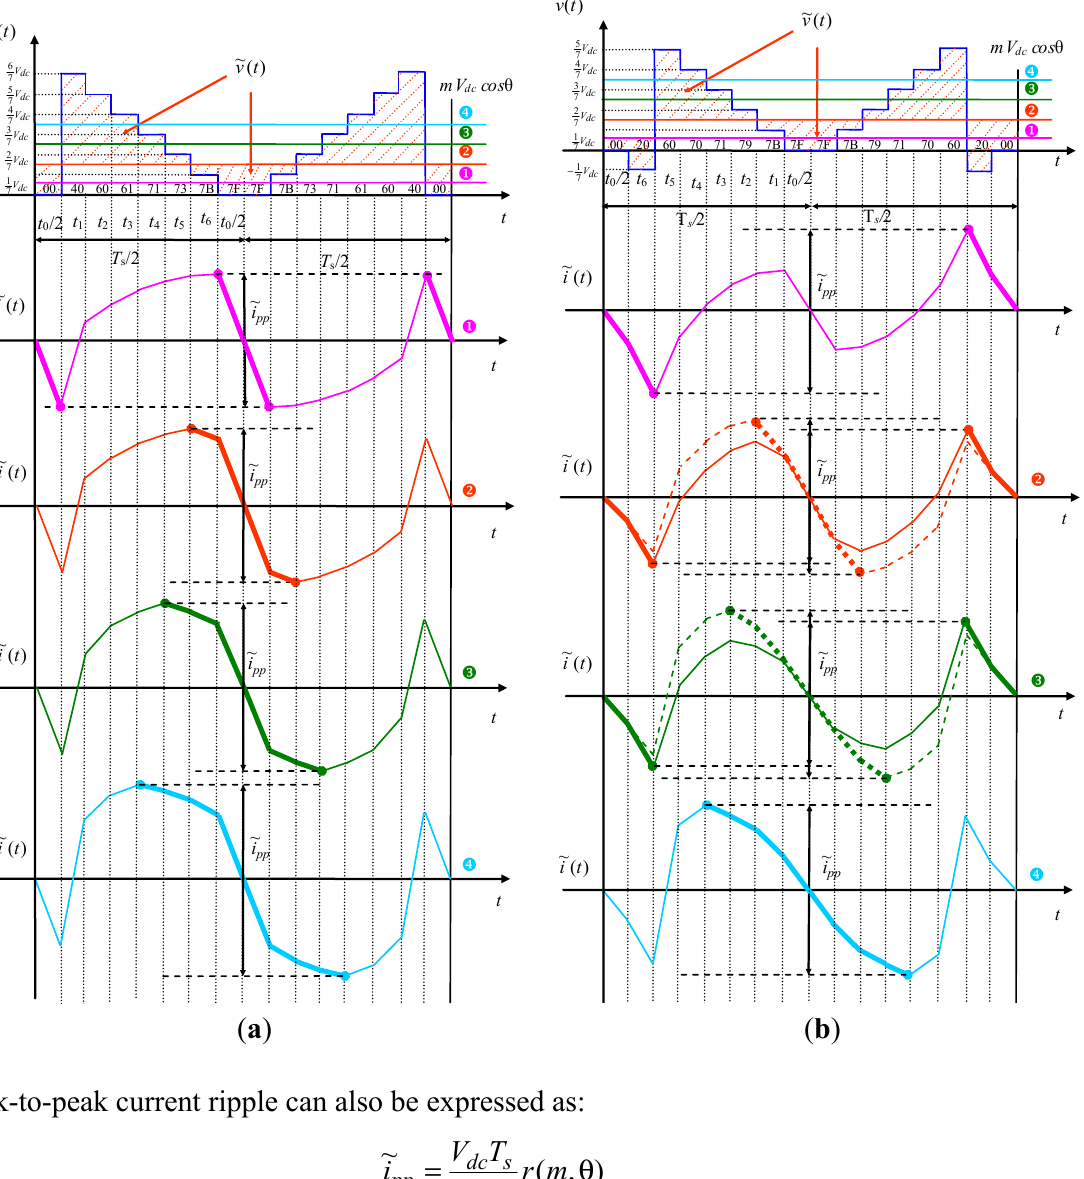
Figure 5. Output voltage and current ripple in a switching period. ( a ) For sector  , 0 ≤ θ ≤ π /7; and ( b ) for sector  , π /7 ≤ θ ≤ 2 π